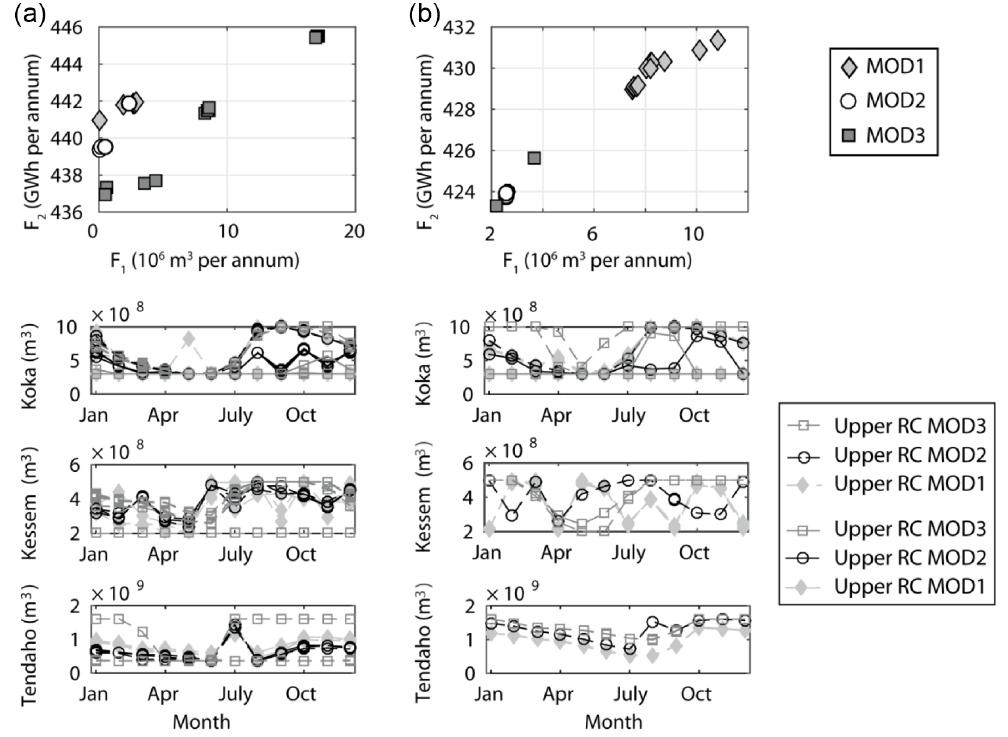
Figure 3. Pareto-Fronts and rule curves (RC) for all solutions from a specific model for (a) recent conditions and (b) the future development plan. Note for (a) and (b) that F 1 is to be minimized and F 2 and to be